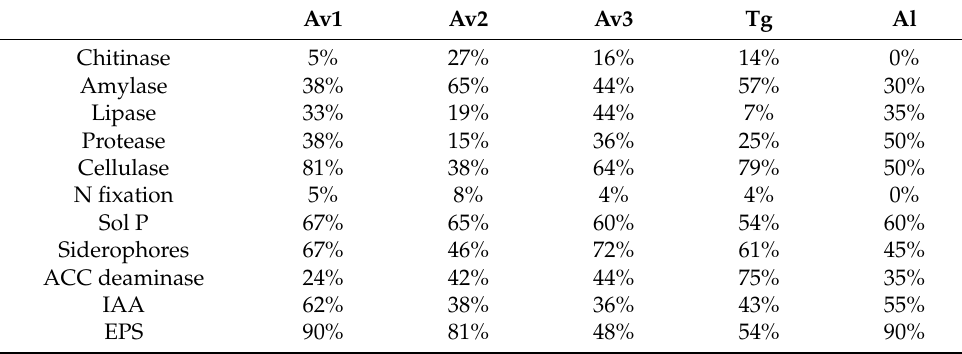
Table A2. Percentage of isolates expressing each PGP trait per sampling